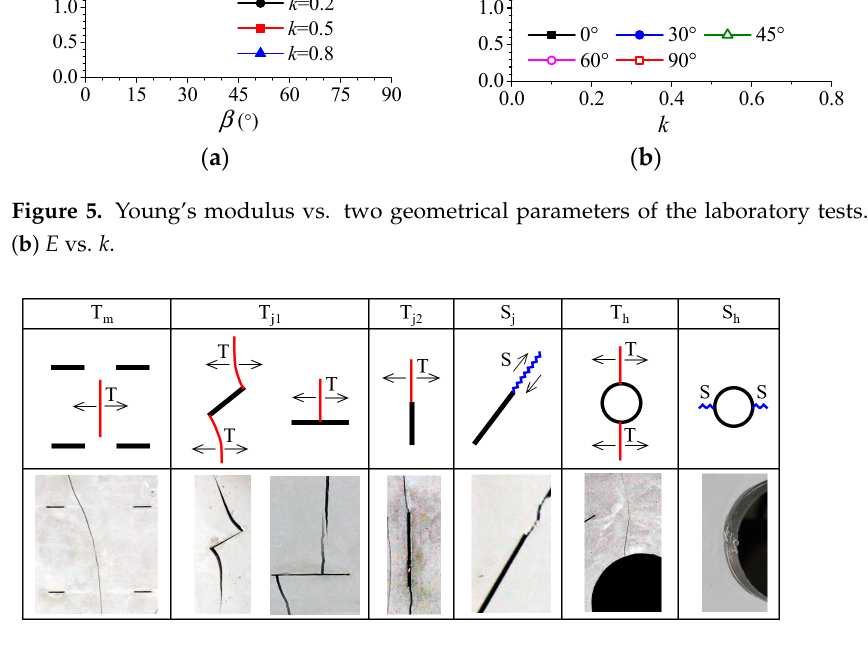
Figure 6. Observed crack initiation types initiated from the matrix, joints, and hole (Red and blue lines represent tensile or shear cracks, respectively).